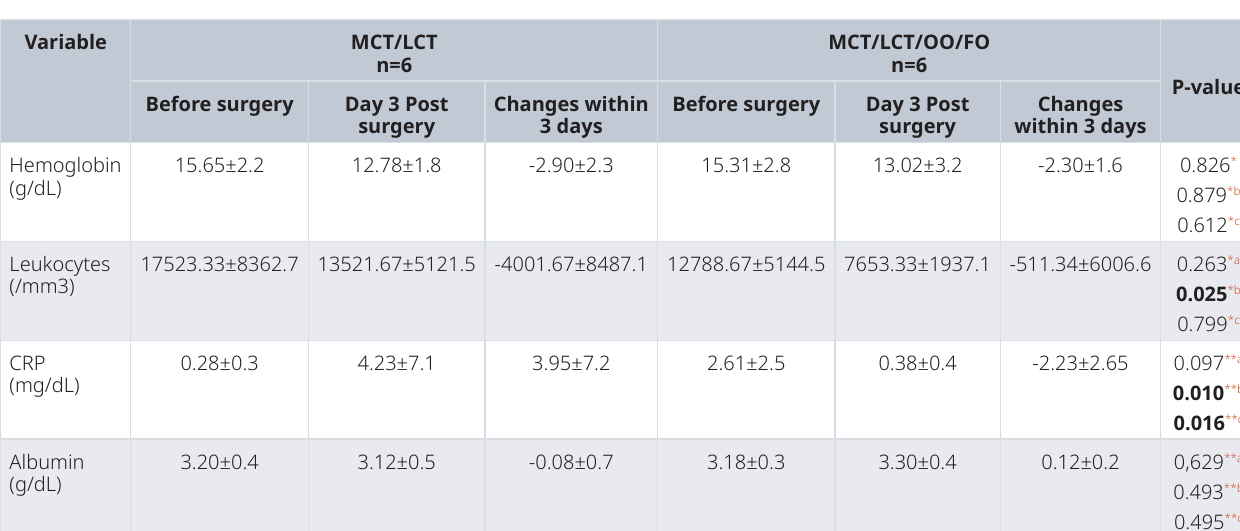
Table 5. Laboratory parameters in